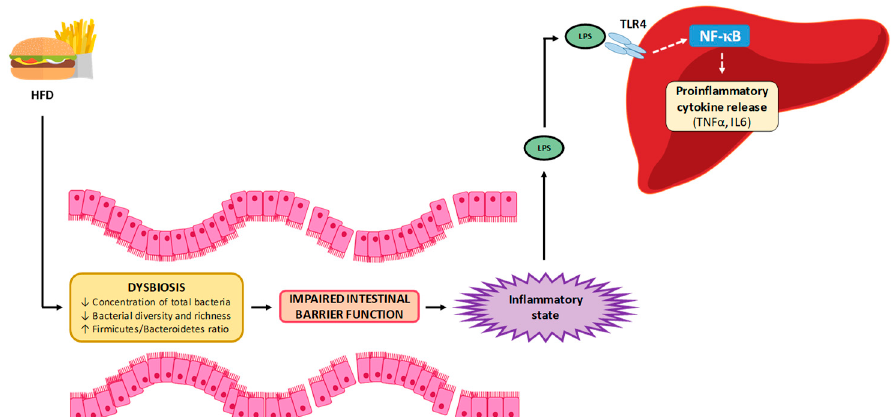
Figure 1. Involvement of inflammation, induced by changes in microbiota associated with high-fat feeding, in liver steatosis development. (Based on Porras et al., 2018 [70]). HFD: High-fat diet, LPS: lipopolysaccharide, TLR-4: Toll-like receptor 4, NF- κ B: Nuclear factor κ B, TNF- α : Tumor necrosis factor α , IL-6: Interleukin-6.